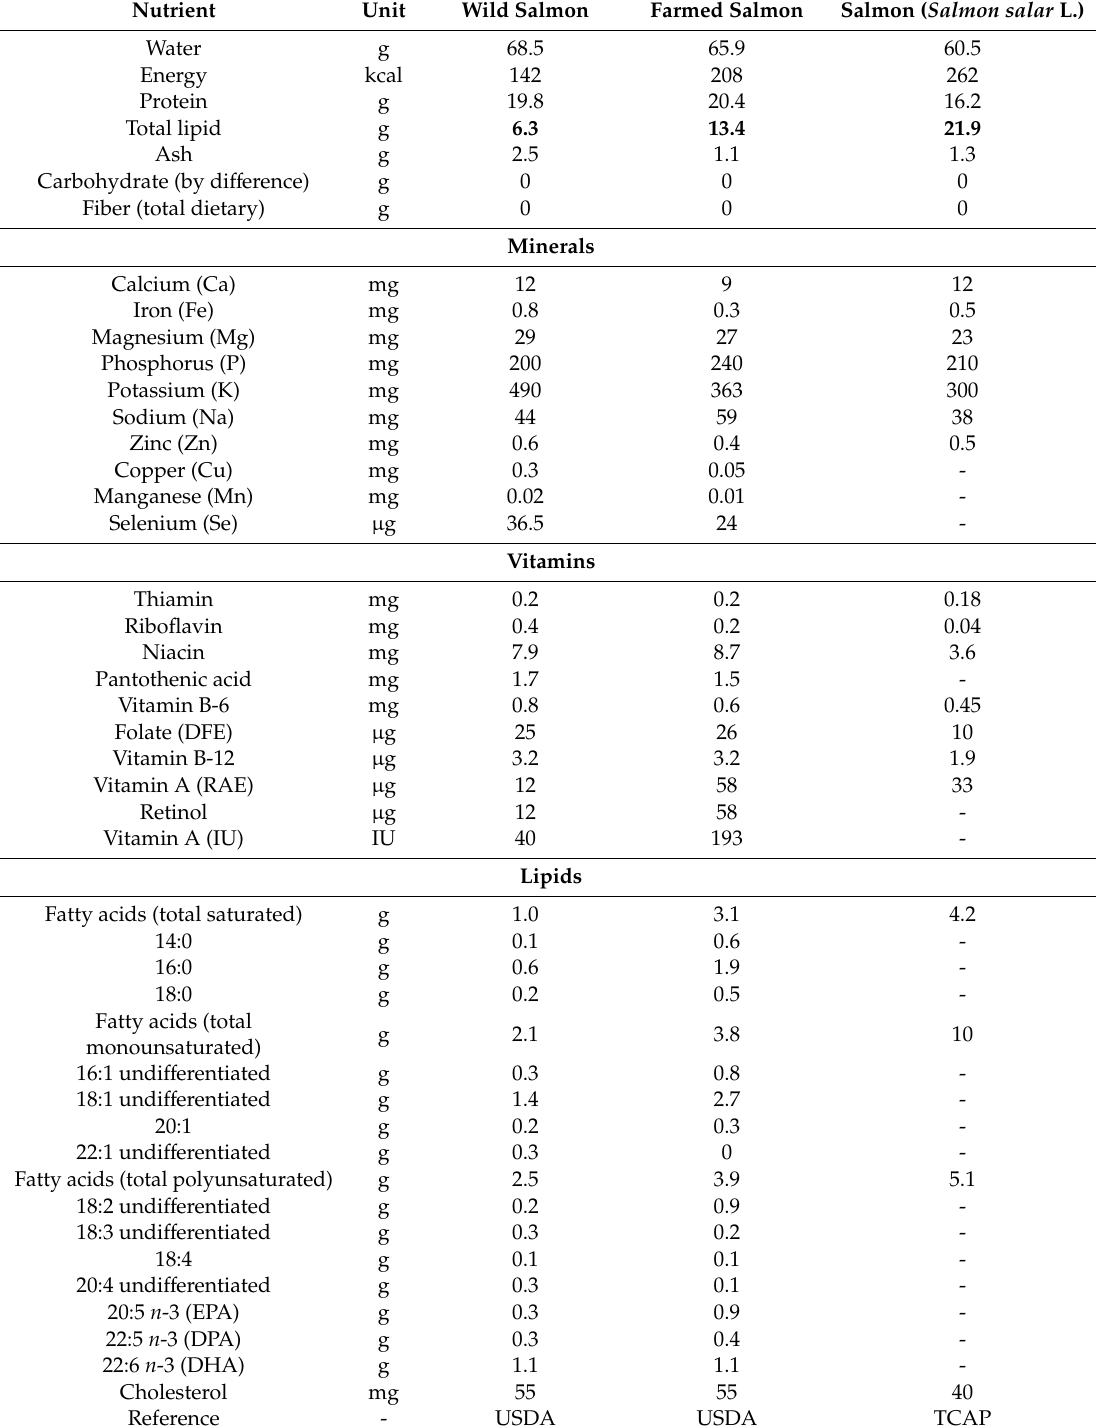
Table 4. Fresh salmon ( Salmon salar L.) nutritional composition according to the Portuguese Food Composition Table [47] and the United States Department of Agriculture (USDA, 2018) [48] Values per 100